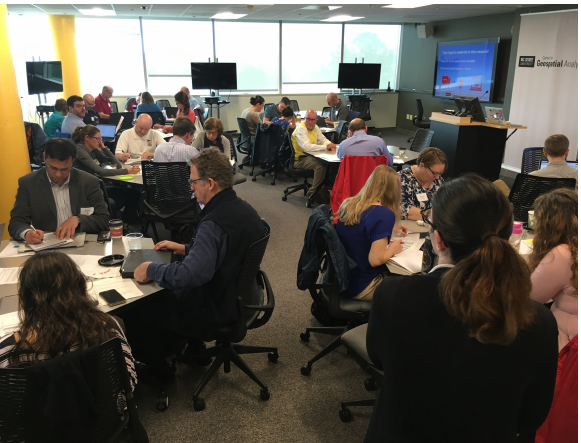
Figure 2. Stakeholders representing planning and policy professionals from across the Research Triangle, NC, participated in a workshop held at the Center for Geospatial Analytics at North Carolina State University to co-design stormwater management